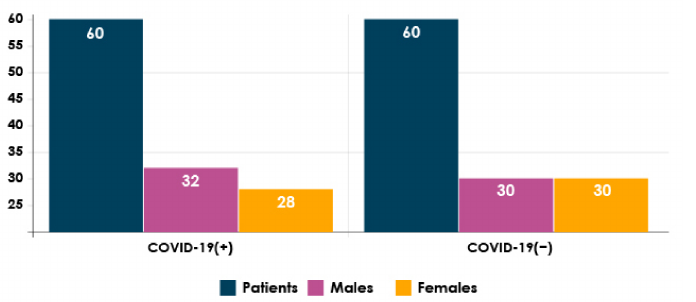
Figure 2. The detailed number of patients considered to compose SARS-CoV-2 CT-scan dataset [42].